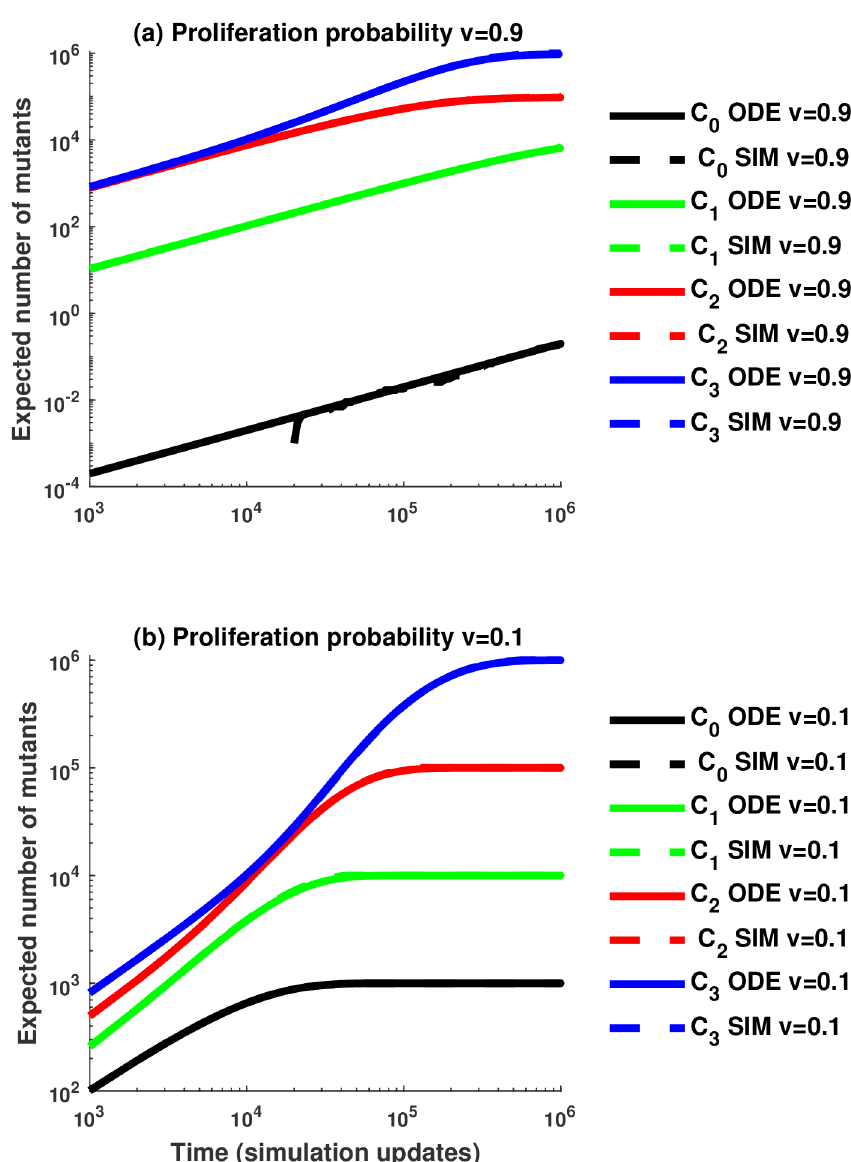
Fig 3. Comparison between the average number of mutants from 100 stochastic simulations without replacement and the number of mutants predicted by the ODE approximation. (a) Comparing the number of mutants for a high value of the proliferation probability, v = 0.9. (b) Comparing the number of mutants when the proliferation probability is small, v = 0.1. Solid lines correspond to the number of mutants in compartment C i , i = 1, ... , 3, predicted by the ODE approximation and dashed lines correspond to the mean number of mutants in compartment C stochastic simulations. We assume n = 3, a mutation rate of u = 10 −3 , and the compartment sizes are N 0 = 1063, N 1 = 10 4 , N 2 = 10 5 , N 3 = 10 6